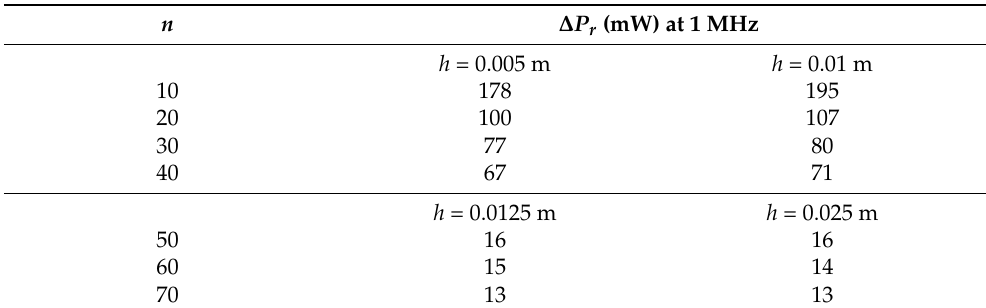
Table 9. Difference between the maximum load power values at 1 MHz for cases with and without skin